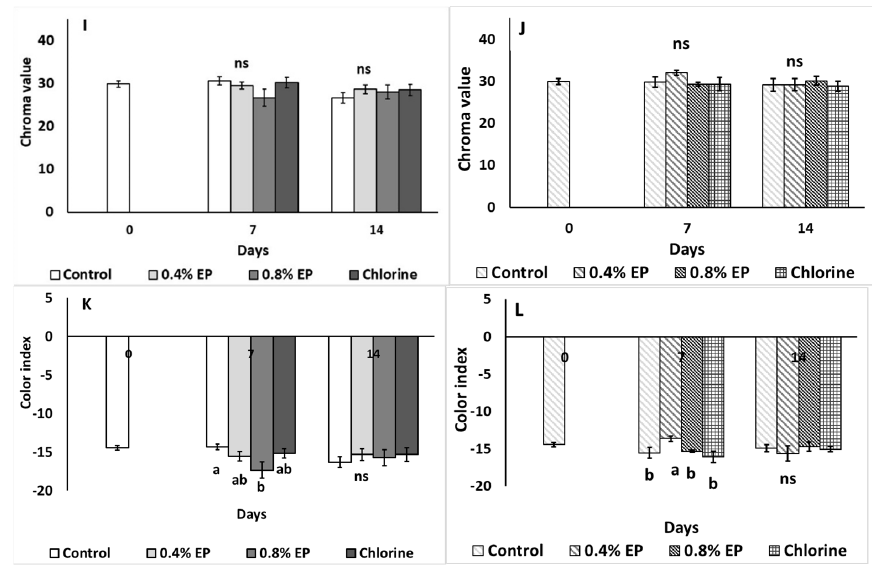
Figure 6. Effects of vapor ( A , C , E , G , I , K ) or dipping ( B , D , F , H , J , L ) application with eco-product (EP) at different concentration (0–0.4% and 0.8%), chlorine (0.02%) or control (application with water) on color attributes of cucumber fruits stored at 11 °C and RH ~90% up to 14 days. Means ± SE followed by different Latin letters are significantly different according to Duncan’s MRT ( p = 0.05). ns: not significant.